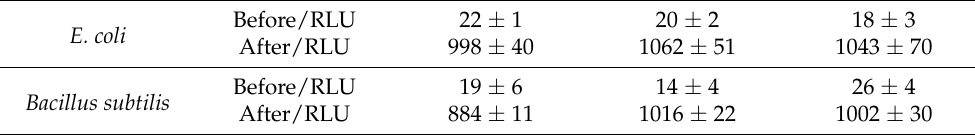
Table 2. Magnetic capture efficiency of Fe 3 O 4 @PDA@PEI MBs on Bacillus subtilis and E. coli